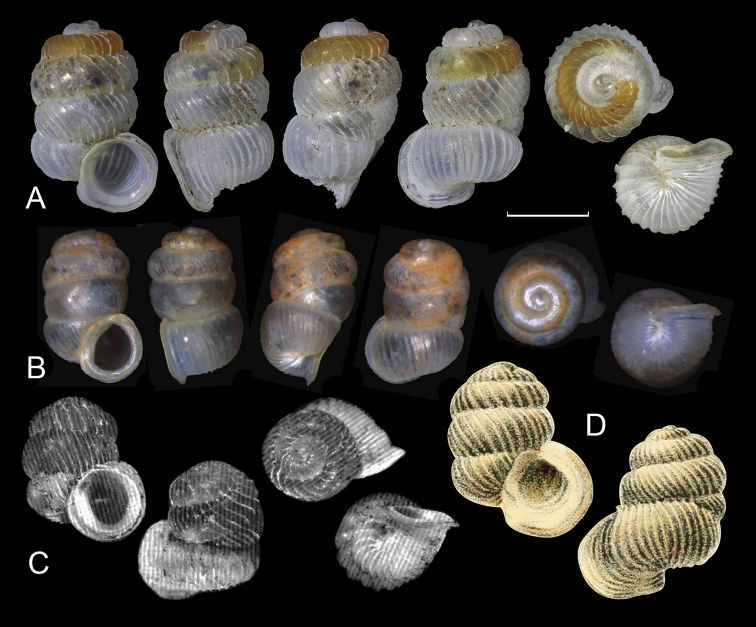
ASinoarinia
feii Chen, gen. et sp. nov. (HBUMM 10016-spec. 1, holotype) (Photos: Zhe-Yu Chen) BSinoarinia
maolanensis (Zhang et al., 2013) comb. nov. (after Zhang et al. 2013) CSinoarinia
mirifica (Li et al., 2005) comb. nov. (after Li et al. 2005) DSinoarinia
aesopus (Bavay & Dautzenberg, 1904) comb. nov. (after Bavay & Dautzenberg, 1904). Scale bar: 1 mm, refers to A and B only.